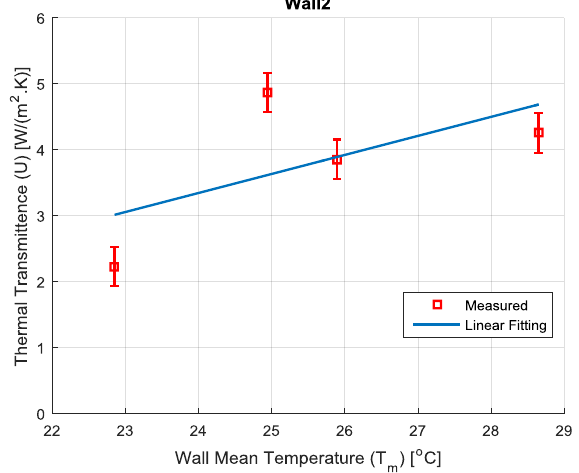
Figure 9. Thermal transmittance of Wall System 2 as a function of the wall mean temperature.